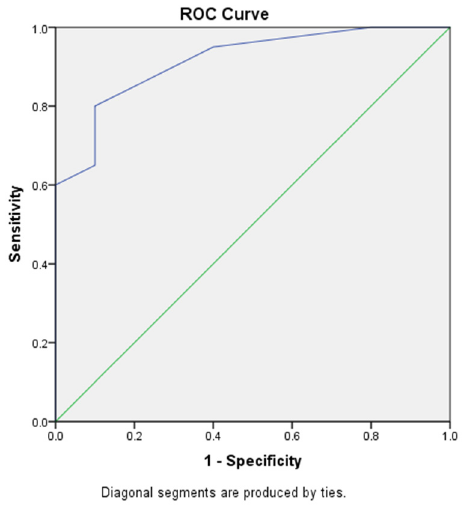
Table 4. Increased salivary flow was found to be a statistically significant protective factor from having laryngeal reflux.